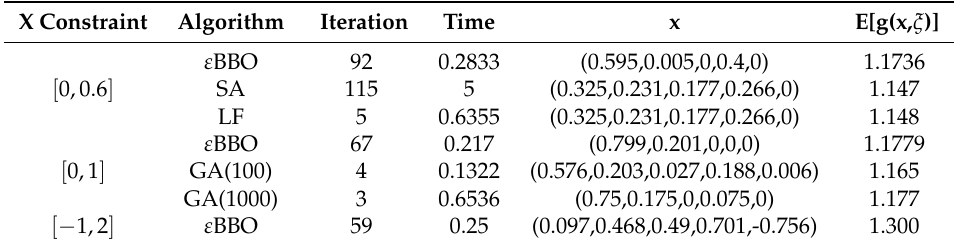
Table 2. The model (28) using date in Table 1. Time is in minute and the expected return of the benchmark portfolio E [ g ( y , ξ )] =